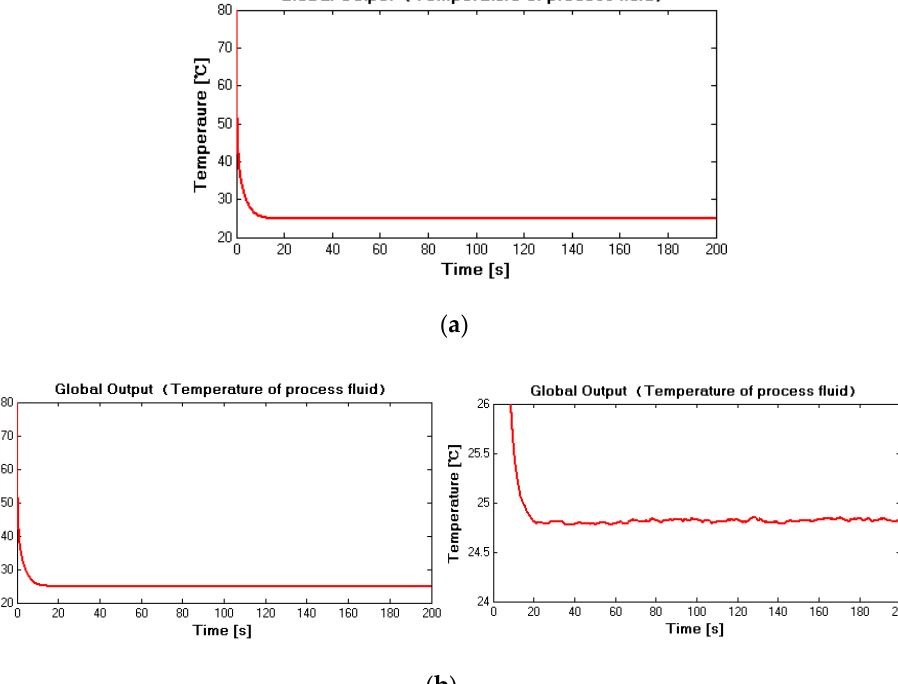
Figure 4. ( a ) Measured T H (noise-free situation) in case 1; ( b ) measured T H (noise-corrupted situation) in case 1.